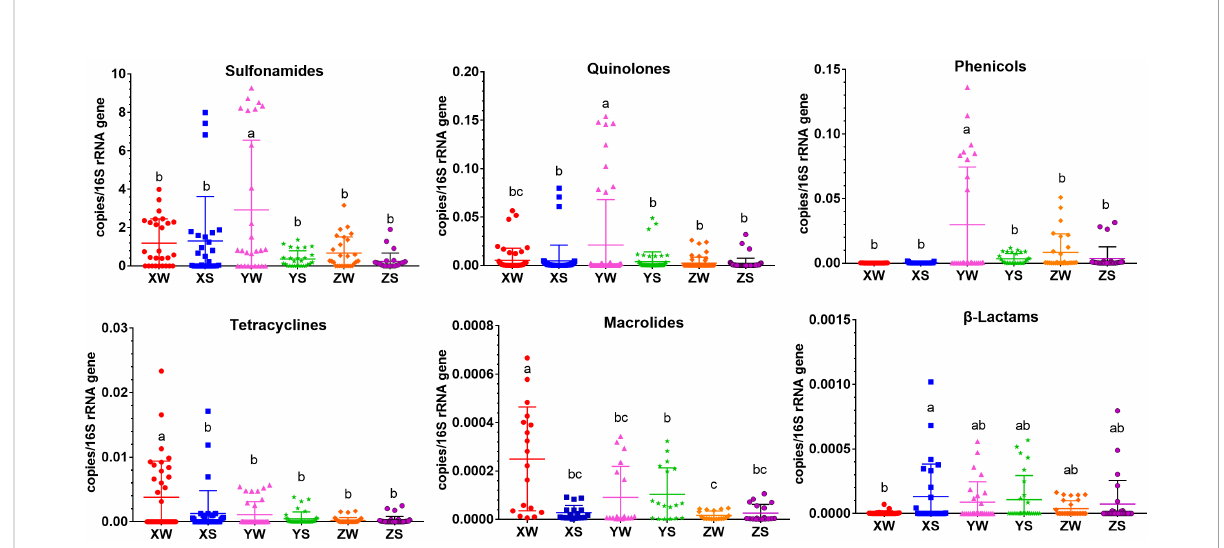
FIGURE 1 Distribution of different classes of ARGs in the water and sediment samples. X, Y, and Z indicate the fi ngerling, rearing, and harvesting stages, respectively, and S and W indicate the pond water and sediment samples, respectively. a,b and c indicate different signi fi cance at P <